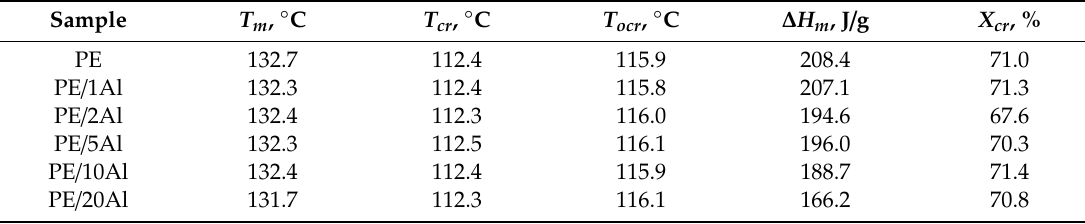
Figure 13. Di ff erential scanning calorimetry (DSC) curves obtained during the second heating ( a ) and the first cooling ( b ) of the samples. Table 2. Thermal properties of pure polyethylene and PE / Al composites determined during di ff erential scanning calorimetry (DSC)